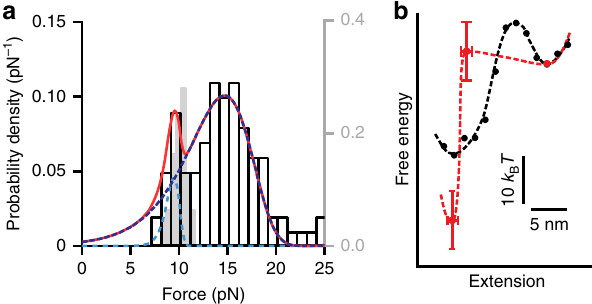
Figure 2 | Effect of Fe-TMPyP binding on unfolding energy landscape. ( a ) The unfolding force distribution (black) for discrete transitions at 50 m M Fe-TMPyP had two peaks, near 9 and 15pN (red: fit to equation 3). The low-force peak (cyan) matches the distribution for unfolding the native structure in the absence of ligand binding (grey; scale on right); the high-force peak (blue) corresponds to the unfolding of ligand-bound native structure. ( b ) Energy landscape for unfolding the native state without (black) and with (red) Fe-TMPyP bound.